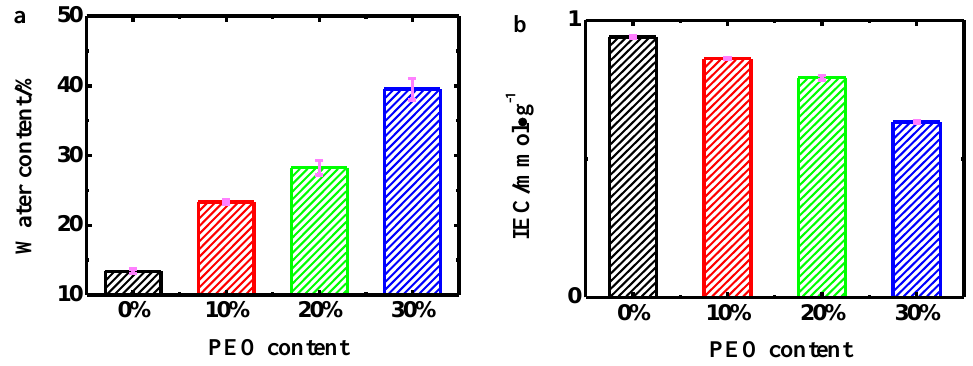
Figure 3. WUR ( a ) and IEC ( b ) of Nafion membranes with varying PEO contents.